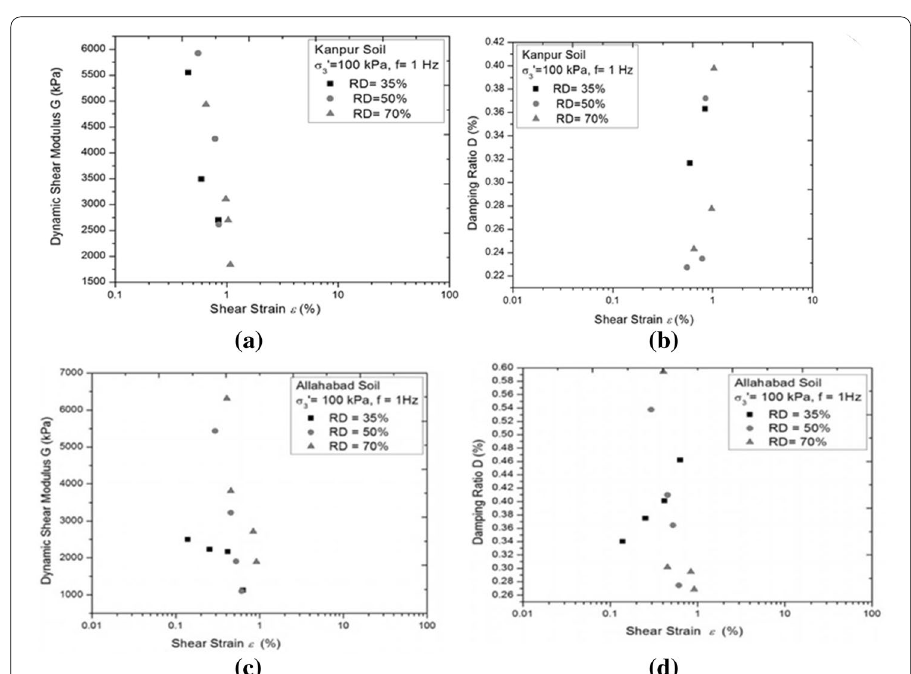
Fig. 13 a Shear modulus and shear strain relationship of Kanpur soil for different relative density. b Damping ratios and shear and strain relationship of Kanpur soil for different relative density. c Shear modulus and shear strain relationship of Allahabad soil for different relative density. d Damping ratios and shear strain relationship of Allahabad soil for different relative density